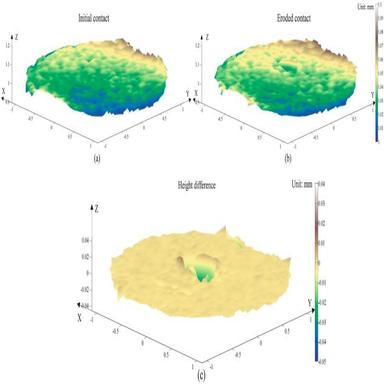
Surface geometries of stationary electrodes. (a) Initial electrode. (b) Eroded electrode caused by one single arc. (c) Height differences caused by one single arc.